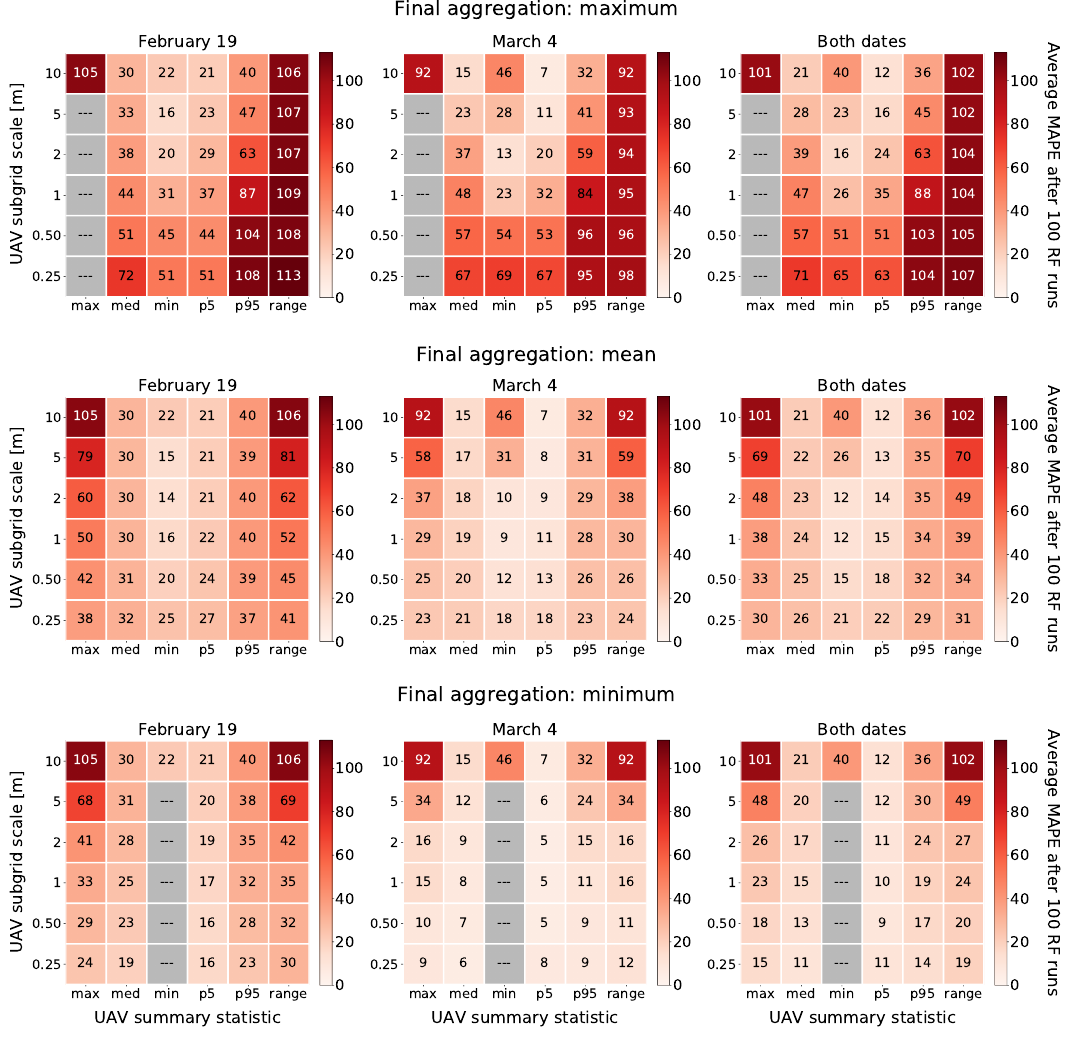
minimum subgrid roughness than by maximum subgrid roughness). For targets with mean and minimum operations for final aggregation, model performance generally improves as the subgrid spatial scale becomes finer. The opposite trend is apparent for targets aggregated by maximum roughness, where MAPE values increase as the subgrid-scale becomes finer. Note that for target metrics originally calculated at 10 m spatial resolution (the top row of cells in each larger grid), model performance does not change with the final aggregation statistic because no operation is required to aggregate the data to the Sentinel-1 grid. Grey cells that do not contain MAPE values represent redundant model runs: for example, calculating the maximum of 1 m subgrid cells and then aggregating to 10 m by again applying the maximum is equivalent to simply calculating the maximum of the original 10 m cell. This type of redundant model run was not conducted and is excluded from analysis.